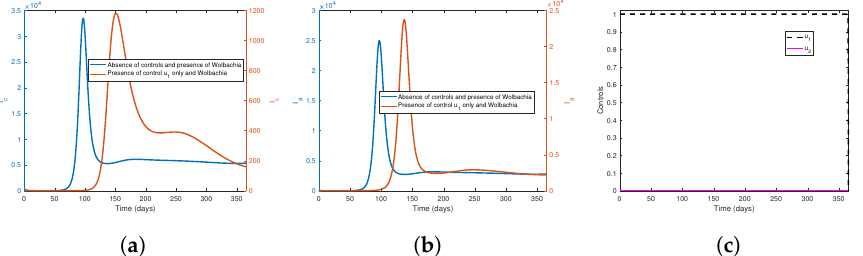
Figure 9. Plots ( a,b ) are the plot of infected child and adult individuals, respectively. Plot ( c ) is the control profile.